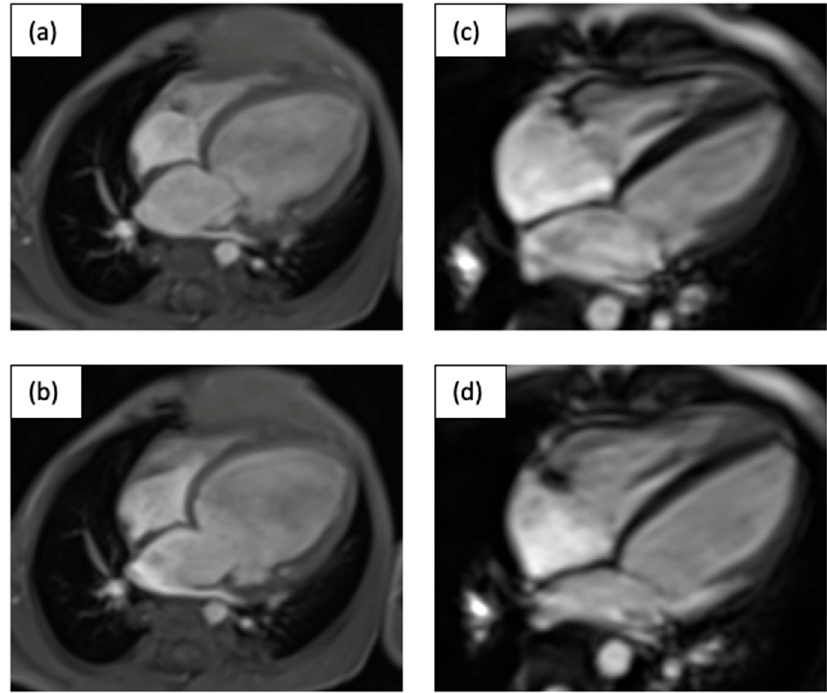
Figure 4. Depicted are systolic ( a , c ) and diastolic ( b , d ) MRI four-chamber views of the 17-month-old child (C.II.1) before ( a , b ) and 10 years after PAB ( c , d ) in systole and diastole. Genetic testing was also performed on first-degree relatives. The pathogenic variant was detected in her mother (C.I.2) as well as in her sister (C.II.2). The mother currently shows moderate functional left ventricular impairment (EF 45%). The sister (C.II.2) has mild functional left ventricular impairment on echocardiography (EF 50%). (pedigree in